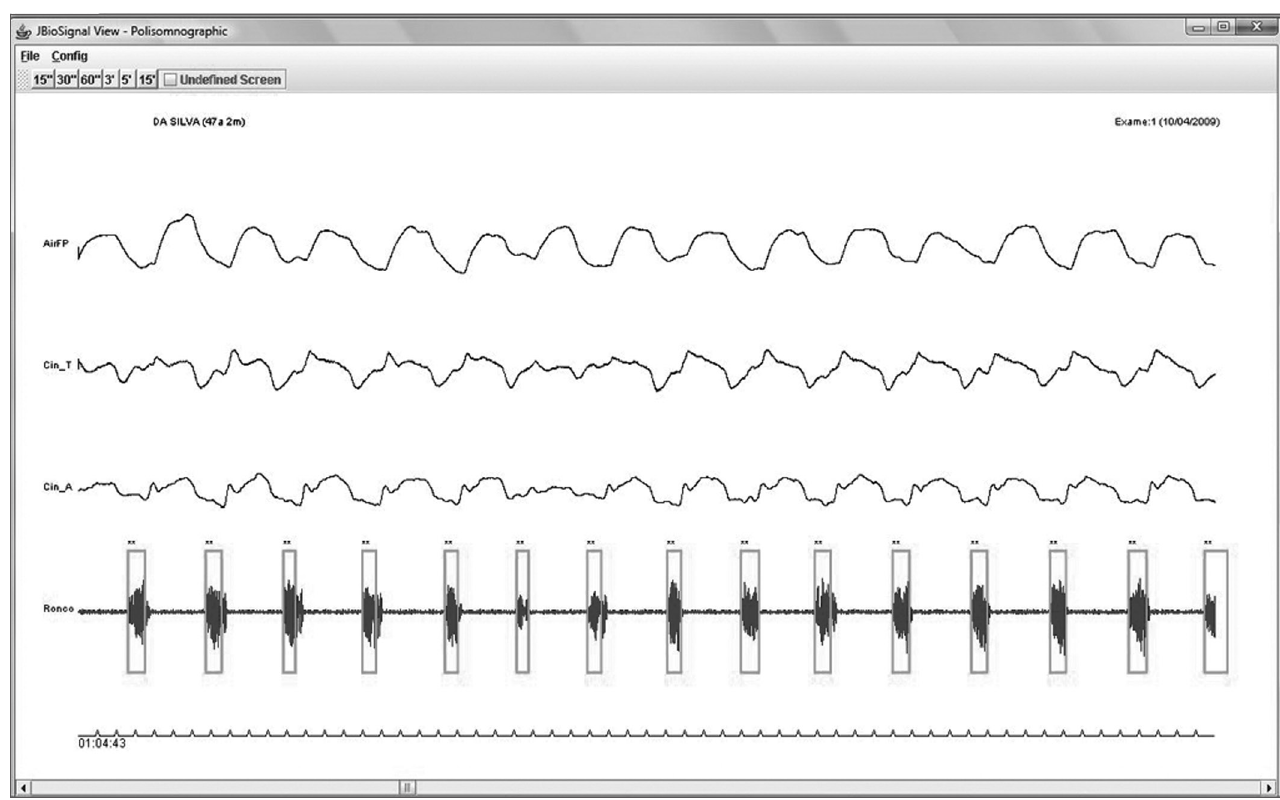
Figure 6. Snoring in phase with the chest and abdominal wall movements and nasal flow - Example of a snoring electric signal in phase with the chest and abdominal wall movements and nasal